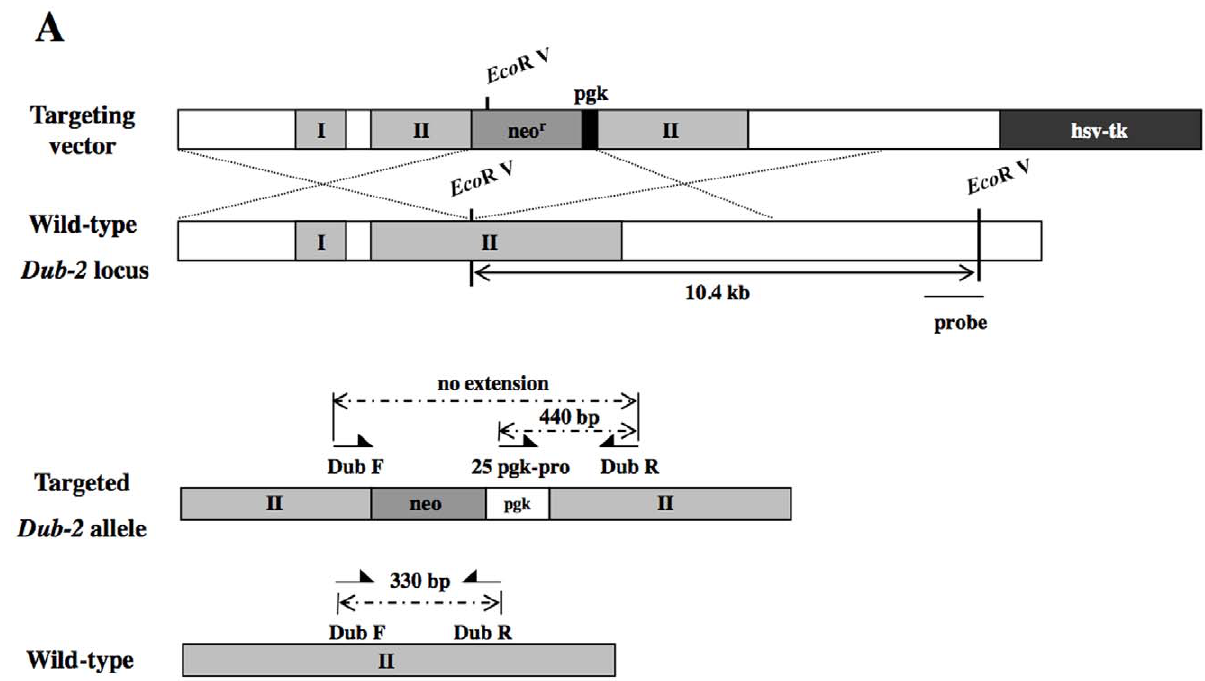
Figure 1. Targeted disruption of the Dub-2 gene. A) Schematic representation of the targeting vector and the targeted allele of Dub-2 gene. Dub-2 is composed of two exons and exon II is disrupted in a targeting vector. Neo r and hsv-tk are used as positive and negative selection markers, respectively. The probe used for Southern hybridization is shown as a black bar. Two pairs of arrows below wild-type and targeted alleles indicate the positions of the primers used for genotyping. B) Southern blot analysis of genomic DNA from targeted Dub-2 ES cells with the probe to distinguish targeted (12.2 kb) allele from wild-type (10.4 kb) allele. C) Genotyping by genomic PCR. The 440 bp band is amplified by using three kinds of primer (Dub F, Dub R, and 25 pgk pro). In addition, PCR analysis of genomic DNA extracted from wild-type and Dub-2 + / 2 ES cell clones was performed. The